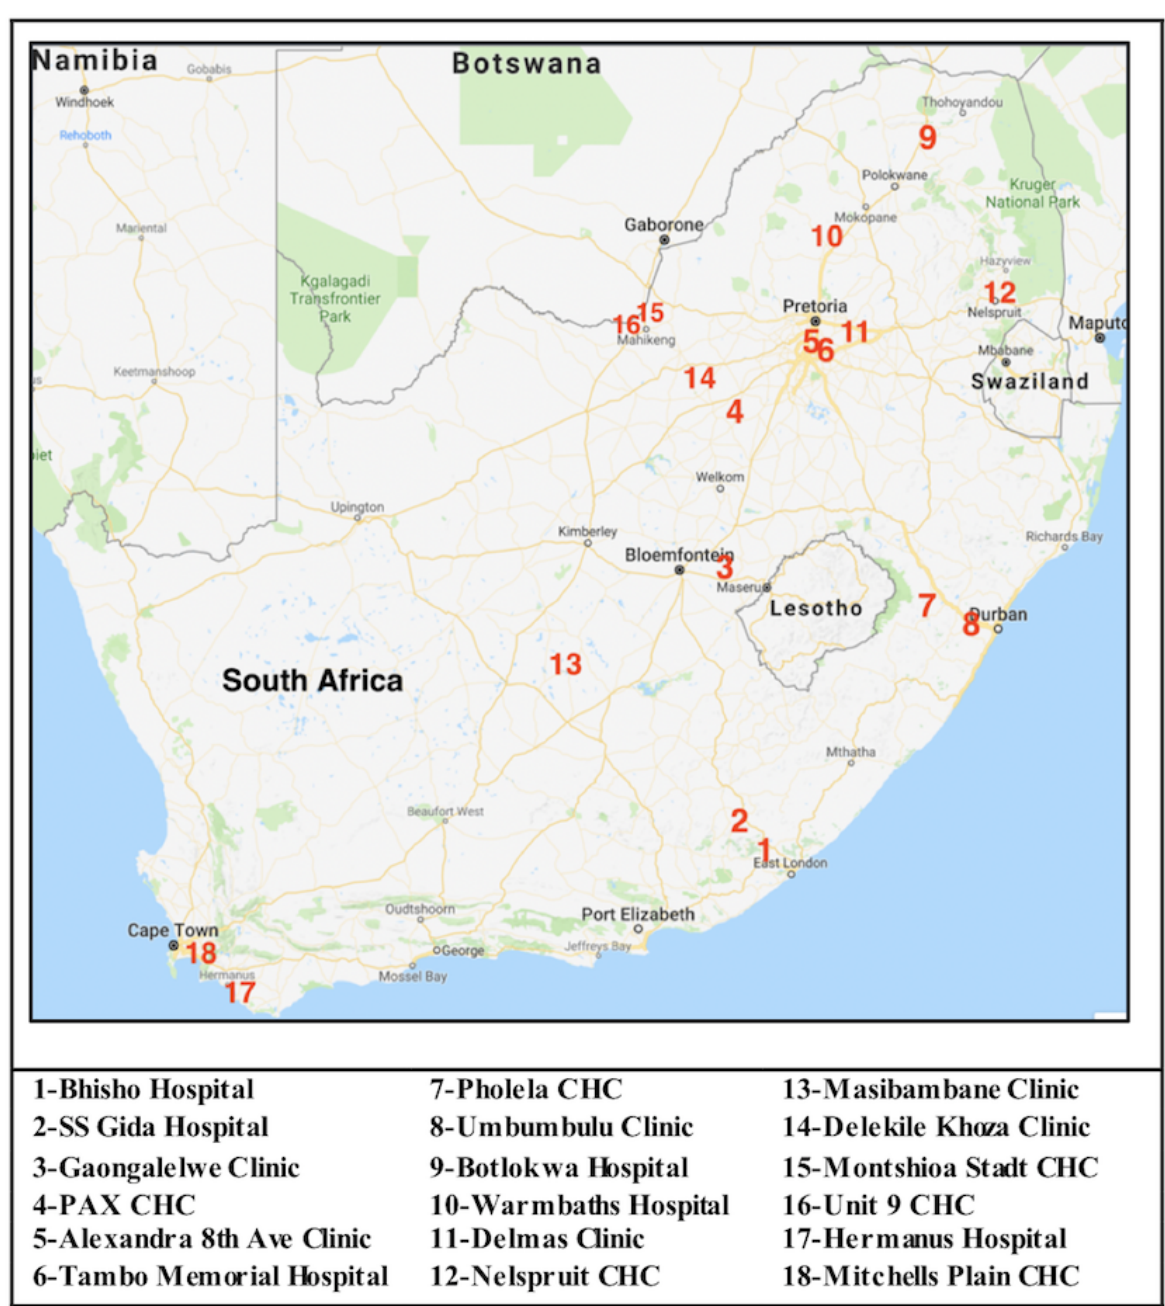
Figure 2. Facility locations. Ave: avenue; CHC: community health